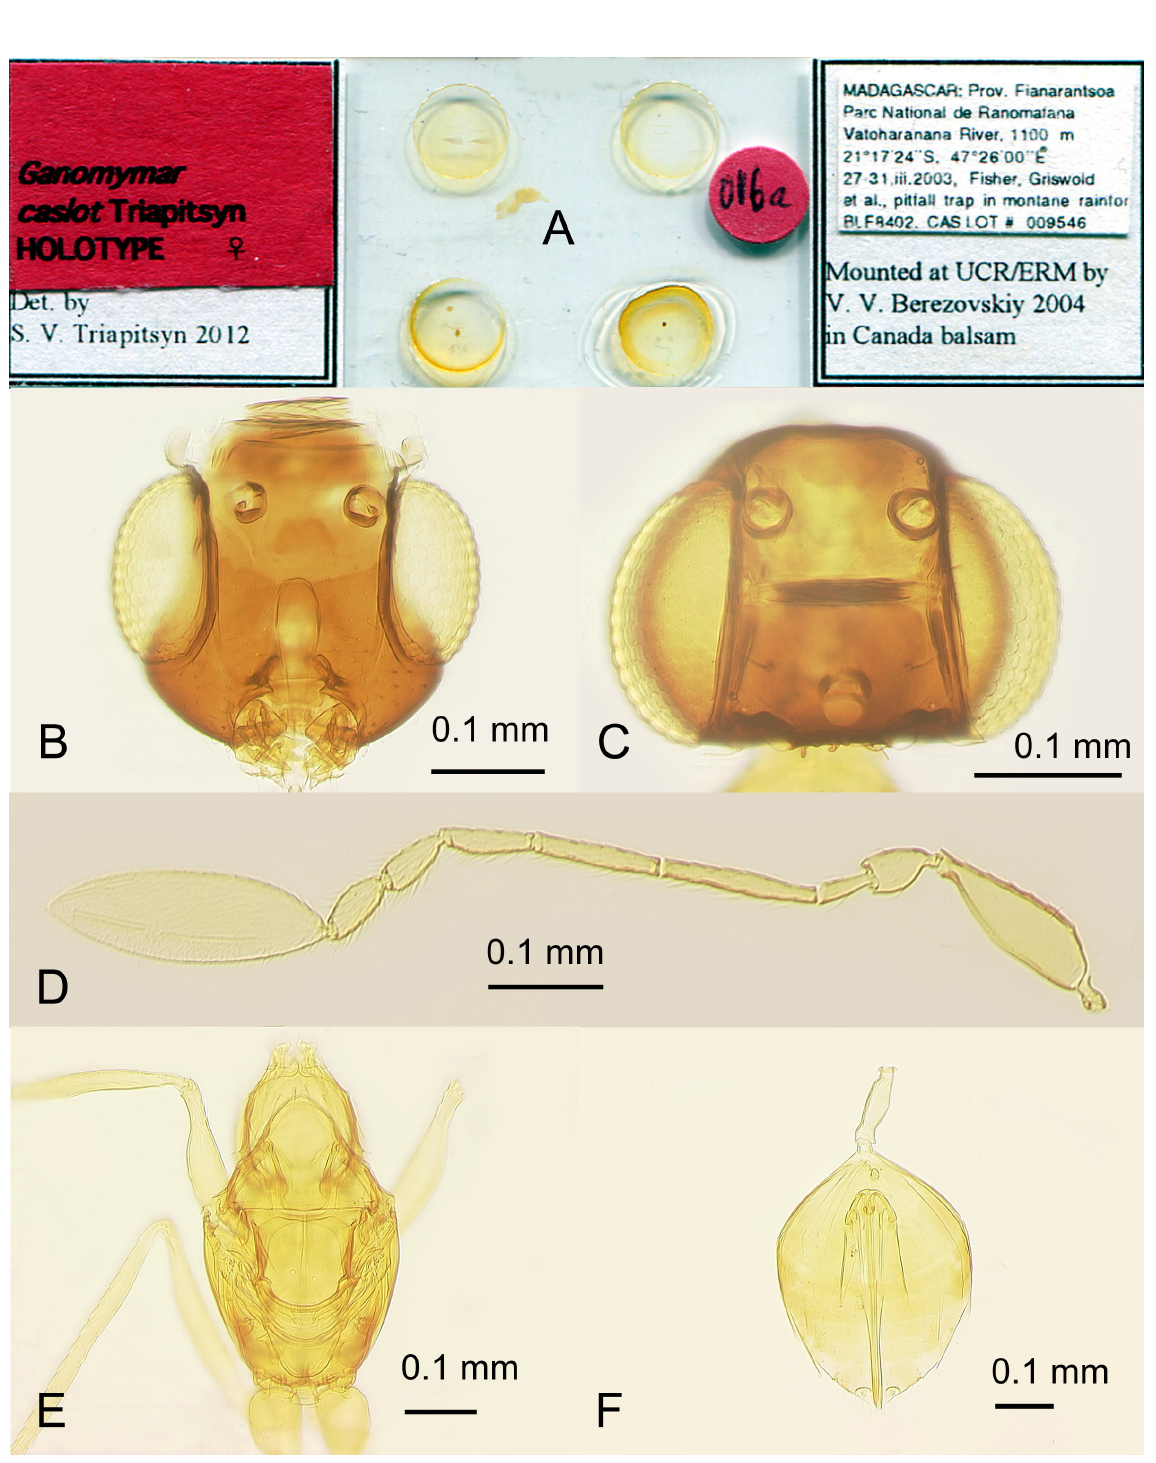
Fig. 2. Ganomymar caslot sp. nov., ♀. A . Holotype slide. B . Head in frontal view, holotype (CAS). C . Head in dorsal view, paratype (CASENT 2079164). D . Antenna, holotype (CAS). E . Mesosoma, holotype (CAS). F . Metasoma, holotype